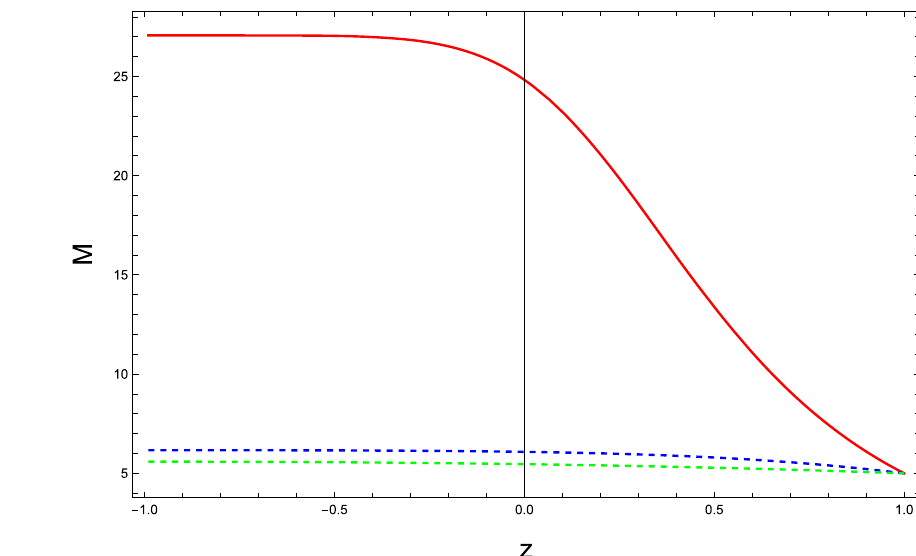
Fig. 10 Evolution of PBH mass M ( z ) with redshift z for MCG (red, solid) and in case of an Emergent Universe considering different ω (dashed). The solid Red curve corresponds to MCG with ω = 0 . 5, the blue and green dashed curves correspond to EU with ω = 1 and ω = 1